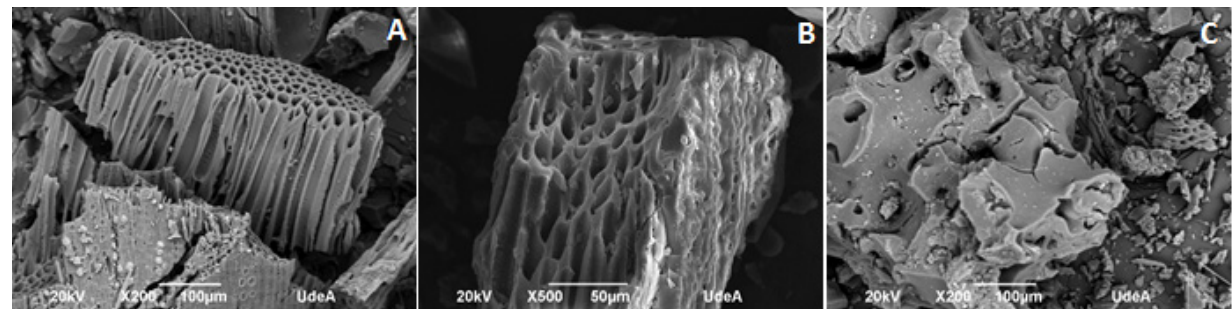
Figure 2. Scanning electron microscopy (SEM) micrographs of the adsorbent materials: ( A ) F Zn (fiber activated with ZnCl 2 ); ( B ) S Zn (shell activated with ZnCl 2 ); and ( C ) F HA (fiber activated with phosphoric acid).